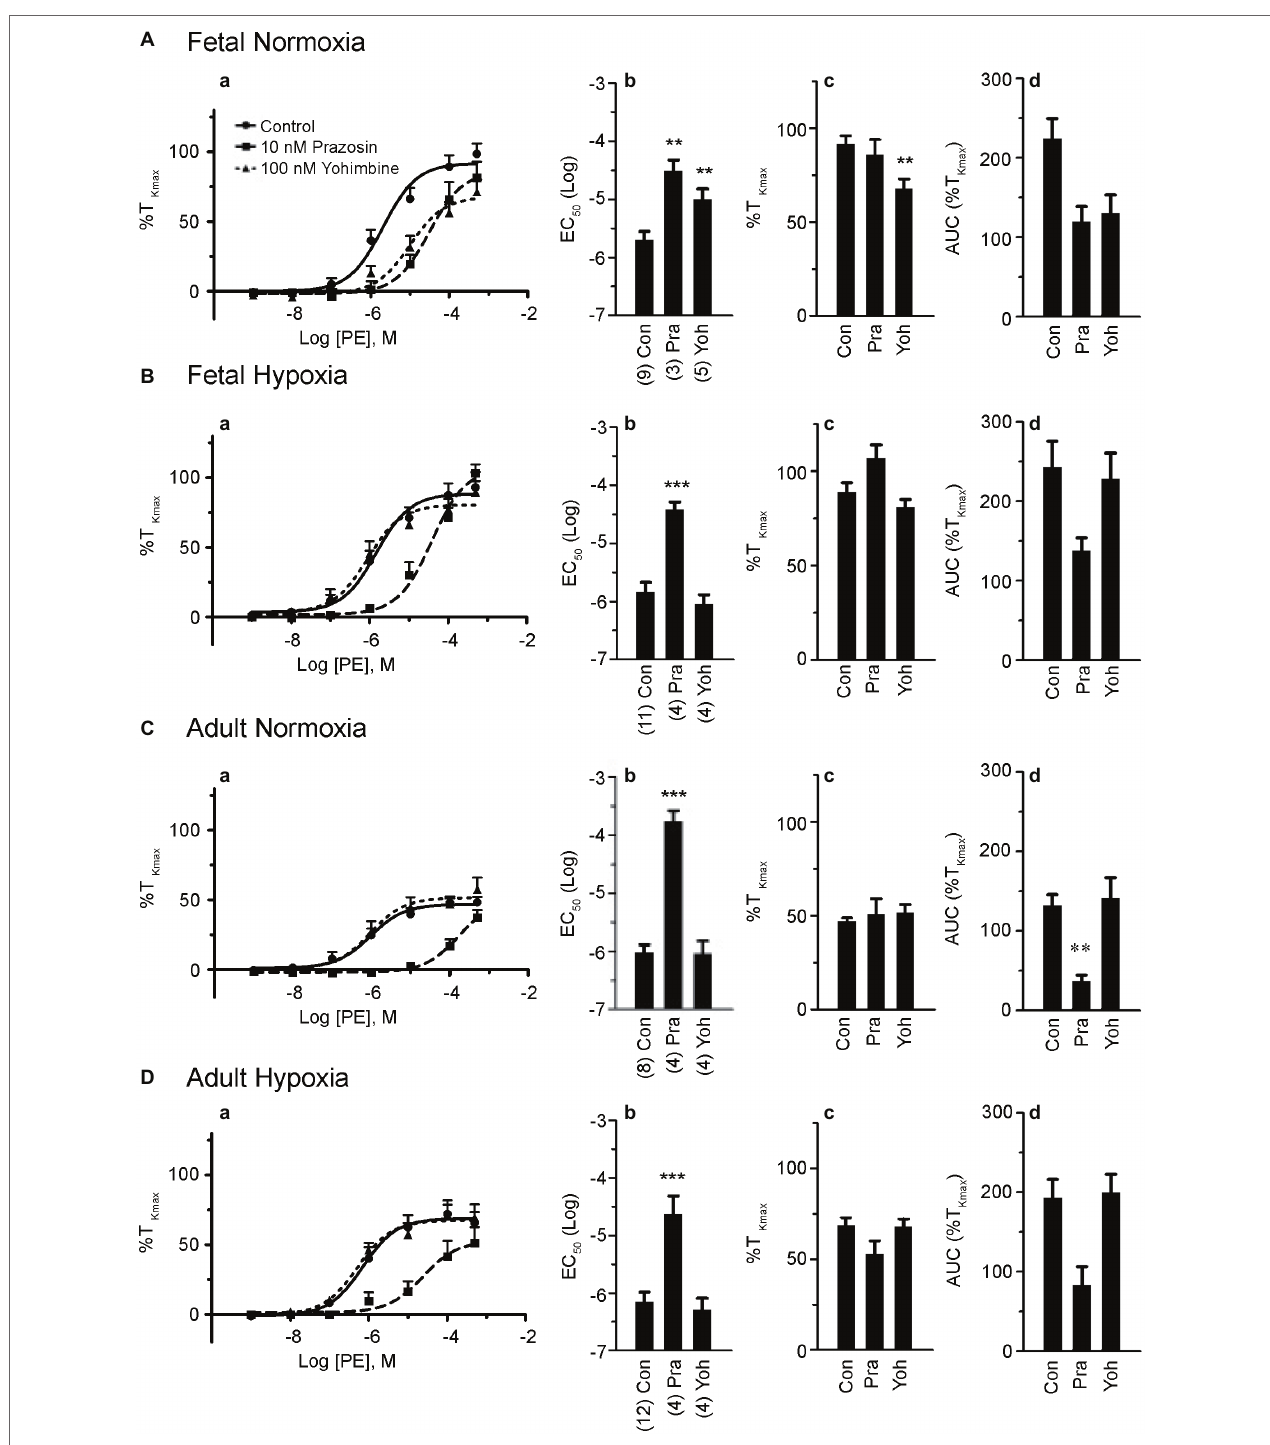
FIGURE 2 | Phenylephrine-induced contraction is largely dependent on α 1 -adrenergic contraction. (a) Dose-response curves of pulmonary arterial rings exposed to 1 nM to 100 μM phenylephrine in an additive manner from normoxic and LTH, fetal (A,B) and adult (C,D) sheep. Solid lines with circles indicate vehicle-control (DMSO) while long dashes and squares indicate 10 nM prazosin and triangles and short dashes indicate 100 nM yohimbine. Log agonist vs. response curves are plotted in relation to the maximal contraction induced by initial stimulation of 125 mM K + Krebs-Henseleit solution (%T Kmax ). (b) Log EC 50 for phenylephrine-induced contraction. (c) Maximum contraction relative to %T Kmax . (d) Area under the dose-response curve relative to high K + contraction. Points and bars are mean values while error bars indicate ± S.E.M. Comparisons of drug treated arteries to control were made using a one-way ANOVA with a Newman-Keuls multiple comparison test (** p < 0.01, *** p < 0.001). Numbers of animals for each fetal and adult group are provided in the “Methods” section and in (b)